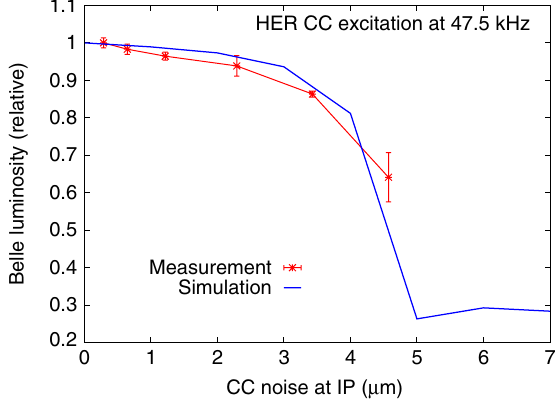
FIG. 1. Luminosity versus HER crab-cavity noise as extrapo- lated to IP displacement. The excitation frequency (0.522 in tune units) is close to the HER horizontal tune. The HER IP nominal horizontal beam size is 180 (cid:3) m .